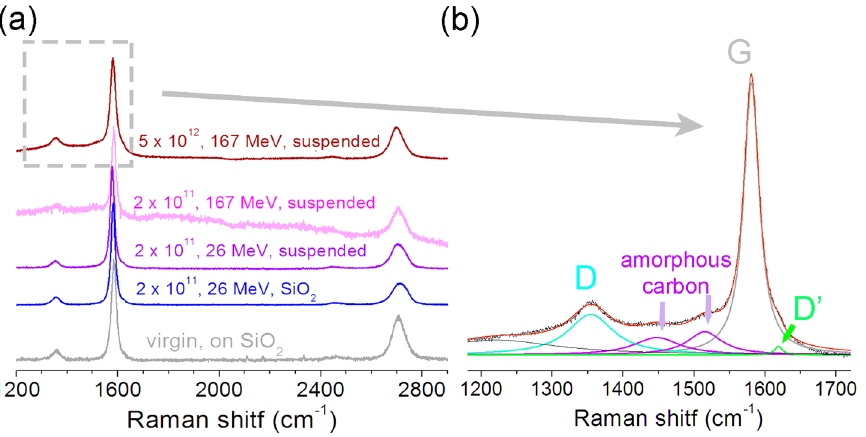
Figure 7. The Raman spectra for pristine and irradiated FLG films transferred before the irradiation onto the SiO 2 /Si substrate or TEM grid, labeled as “on SiO 2 ” or “suspended”, respectively. The dose and ion energy are shown as the first and the second parameters in the image, the type of substrate as the third one. ( b ) The spectra deconvolution into components for the CVD FLG film transferred onto the TEM grid and irradiated by 167 MeV Xe ions with dose at 5 × 10 12 ion/cm 2 . ( a ) A gray dashed square is added to ( a ) to indicate the part shown in ( b ). Table 1. The results of Raman spectra fitting for virgin and irradiated CVD FLG films.